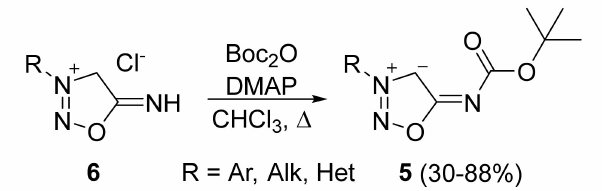
Scheme 3. Interaction of sydnone imine hydrochlorides with Boc 2 O.